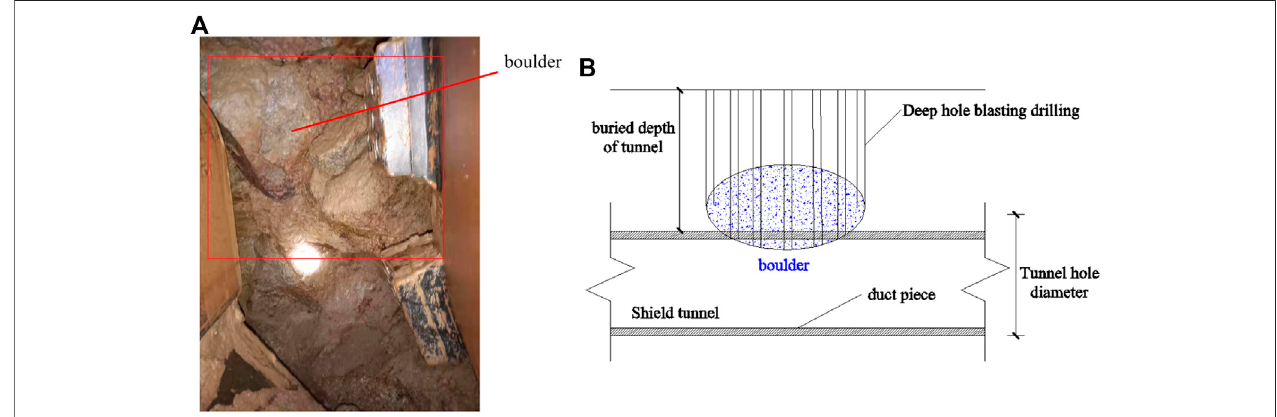
FIGURE 8 | Schematic diagram of location distribution of boulders. (A) Location diagram of the boulder distribution in the left ~ white interval. (B) Schematic diagram of position distribution of boulders in the longitudinal tunnel from left to white interval.